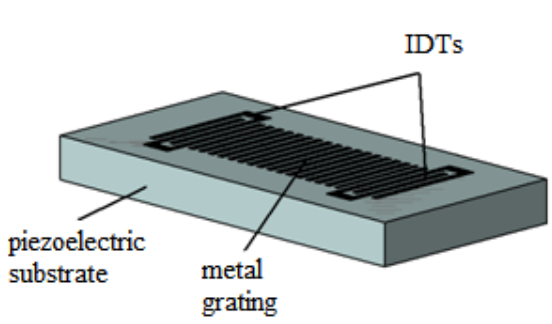
Figure 13. Scheme of a STW device.